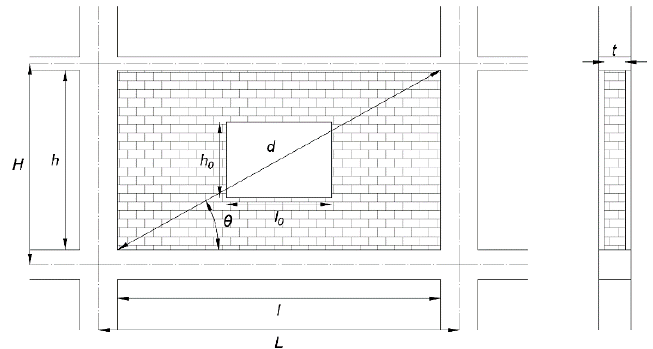
Figure 5. Infill panel geometric properties.